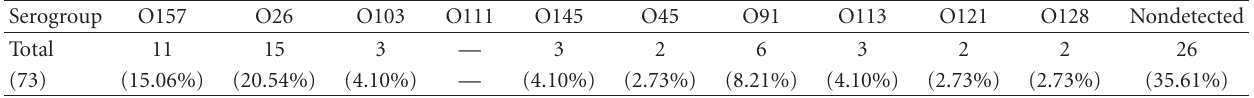
Table 7: Prevalence of Shiga toxin-producing Escherichia coli serogroups isolated from bovine mastitis. Serogroup